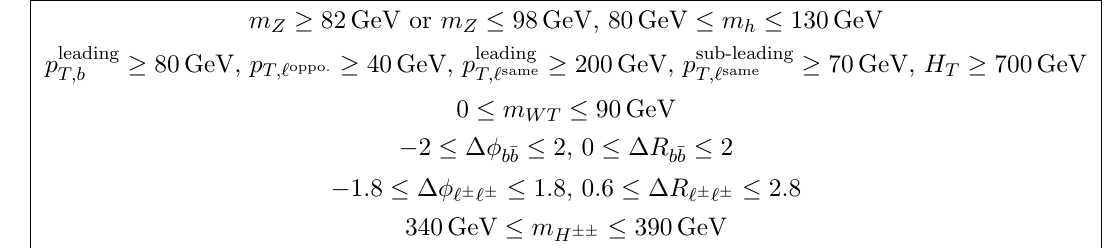
Table 6 . A list of hard cuts for the pp ! H (cid:6)(cid:6) H (cid:7) ! ‘ (cid:6) ‘ (cid:6) hW (cid:7) channel.